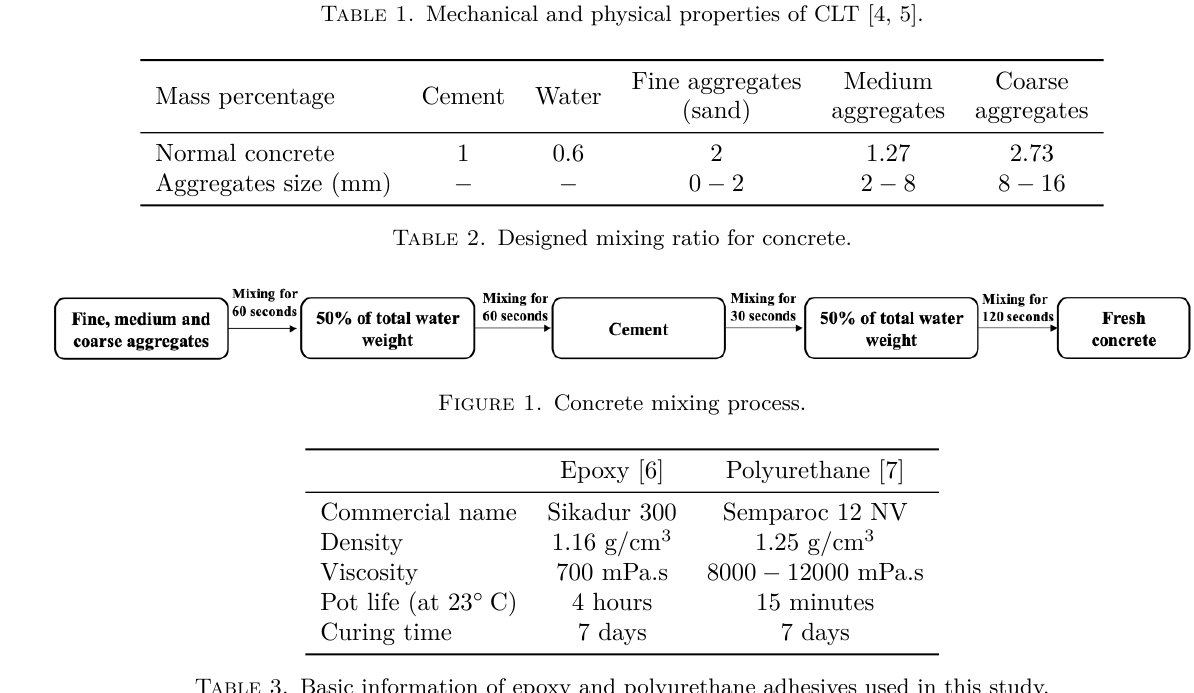
Table 3. Basic information of epoxy and polyurethane adhesives used in this